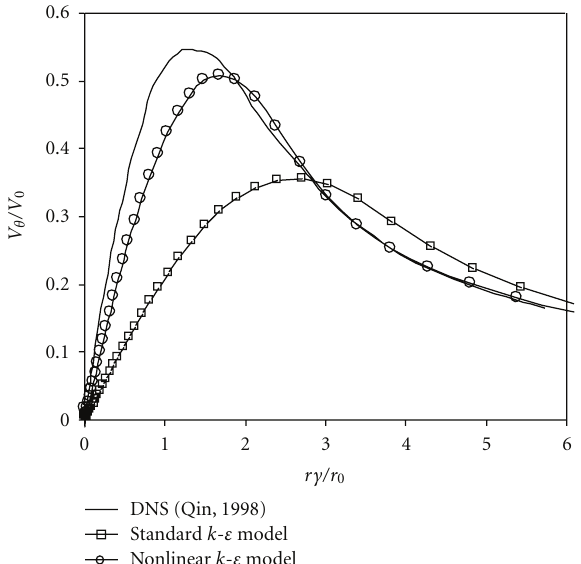
Figure 4: k - ε model prediction of tangential velocity profile com- pared with Qin’s DNS results ( t = 3.72 T ).